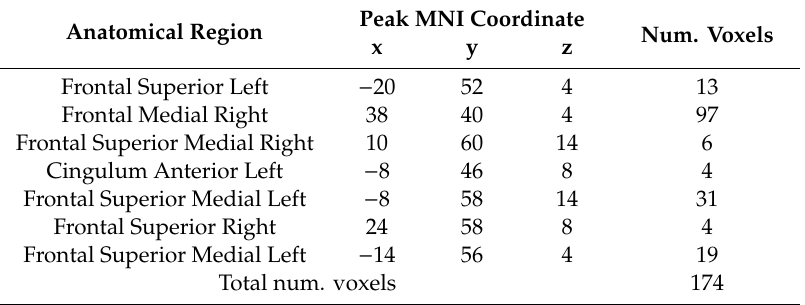
models. Table 1. Representation of number of voxels common by anatomical area between HbO- BOLD (T: 2.33, p < 0.05)